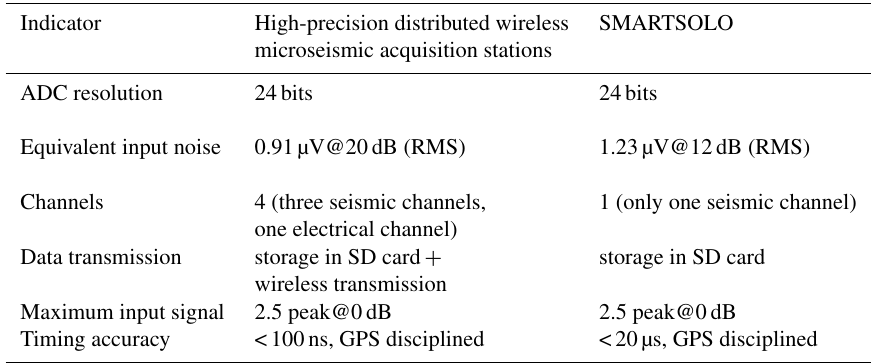
Table 2. Acquisition station performance index comparison